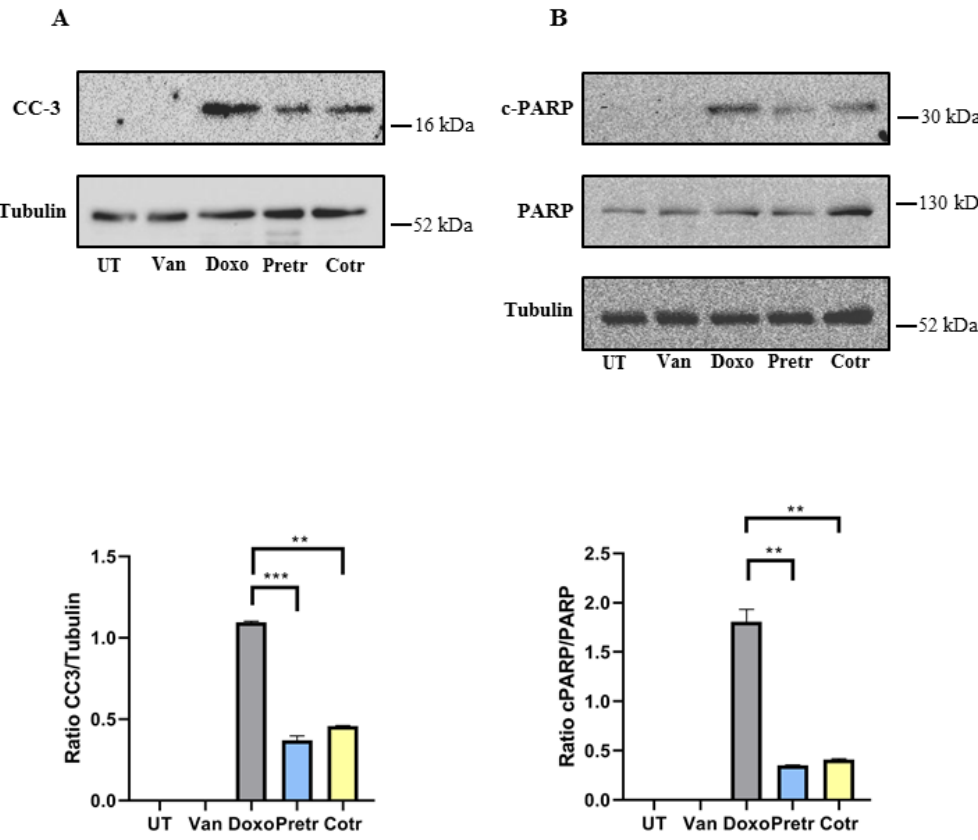
Figure 5. Effect of vanillin on caspase 3 and PARP1 activation. ( A ) Western blot analysis of cleaved caspase-3 (CC3) ( A ), PARP1 and cleaved PARP1 (c-PARP) ( B ) in H9c2 cells exposed to 20-μM doxo for 24 h, pretreated (Pretr) and cotreated (Cotr) with 100-μM vanillin. UT—untreated cells; doxo—cells exposed to 20-μM doxo; Van— cells exposed to 100-μM Van. Images are representative of western blotting from two different cellular extract with similar results. Data represent the average of three independent experiments ± SD. **: p < 0.01; ***: p < 0.001 by one-way ANOVA. Other experimental details are described in Materials and Methods section.